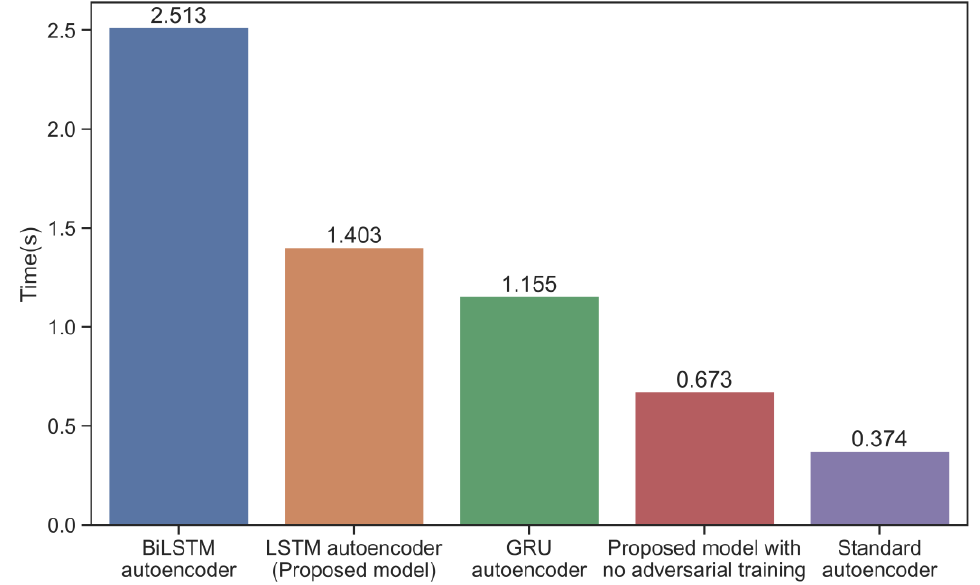
Figure 11. Training time for proposed model and other models.